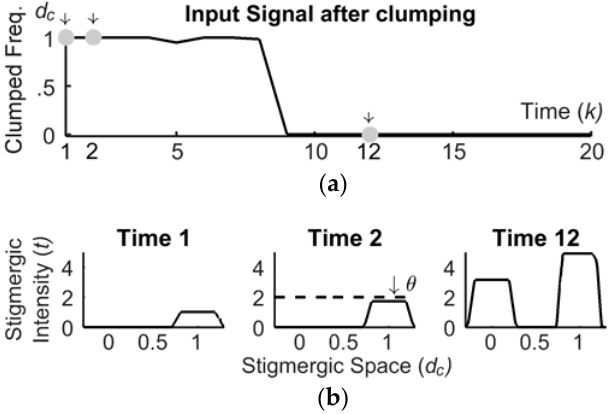
Figure 7. The marking and the trailing processes: ( a ) time domain; ( b ) stigmergy domain.